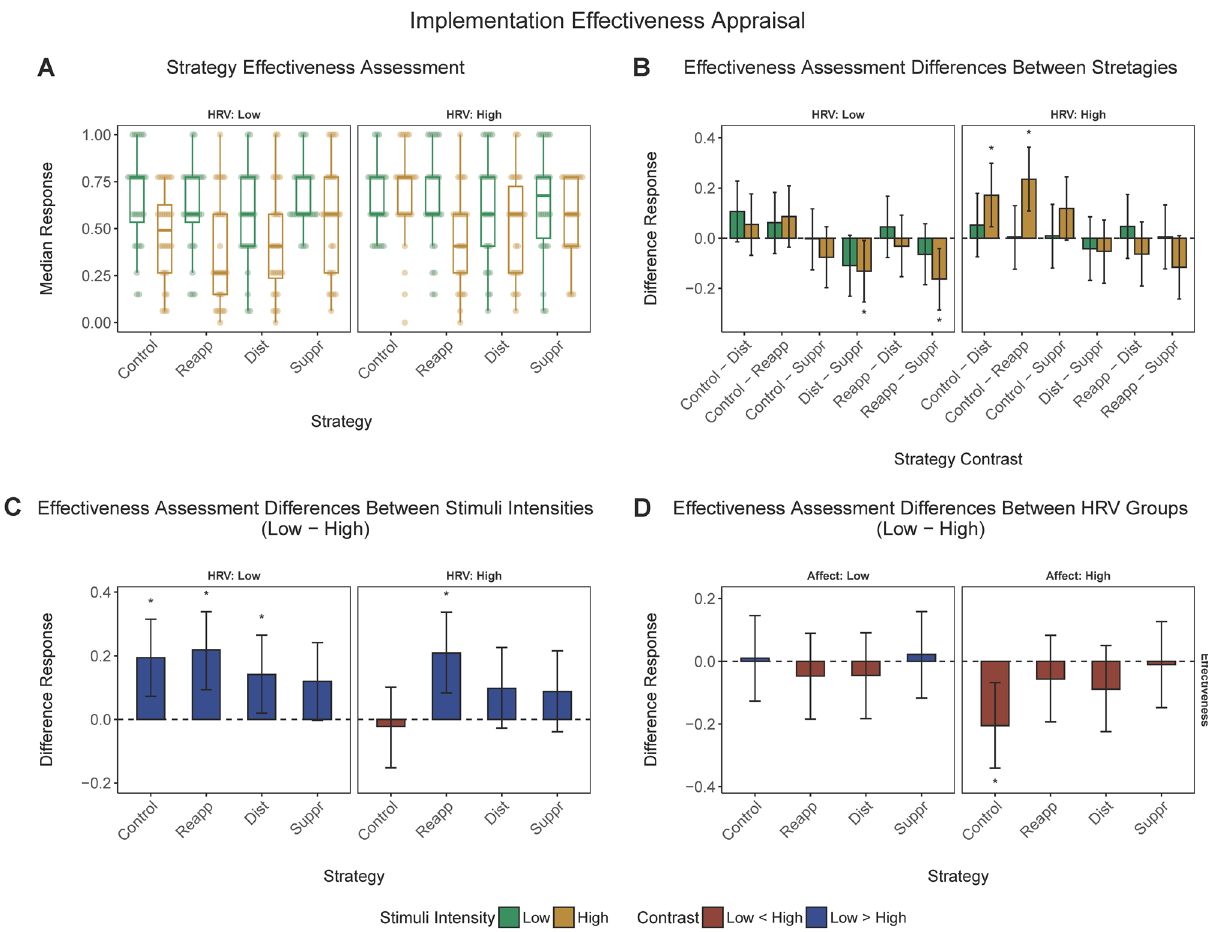
Figure 4. Perceived effectiveness in applying experimental instructions . ( a ) Perceived effectiveness in applying experimental instructions (median) corresponding to low or high negativity stimuli in different experimental conditions and low or high baseline HRV groups. ( b ) Pairwise contrasts of the Perceived effectiveness in applying experimental instructions between emotional regulation conditions corresponding to low or high negativity stimuli in the low or high HRV group. ( c ) Contrasts of the Perceived effectiveness in applying experimental instructions between low and high negativity stimuli across emotional regulation conditions in the low or high HRV group. ( d ) Contrasts of the Perceived effectiveness in applying experimental instructions between low versus high baseline HRV groups. Behavioral responses have been rescaled to a range between 0 and 1. Error bars represent 95% CI of the corresponding estimate. *, significant